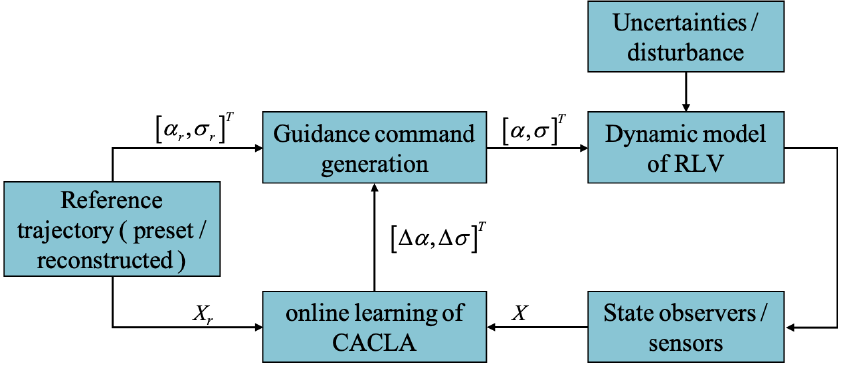
Figure 2. The framework of guidance